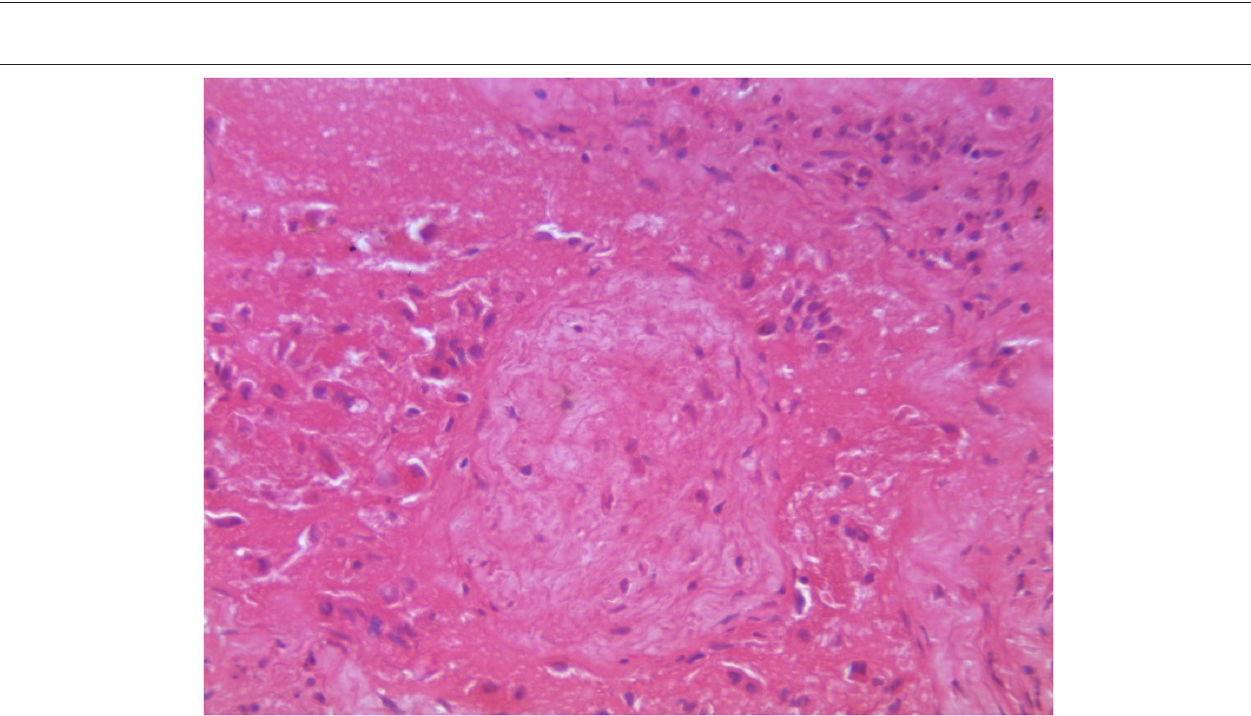
FIGURE 2 | Histopathology of lungs showing characteristic granulomatous reactions with central caseum, recruited inflammatory cells, and a fibrous capsule.